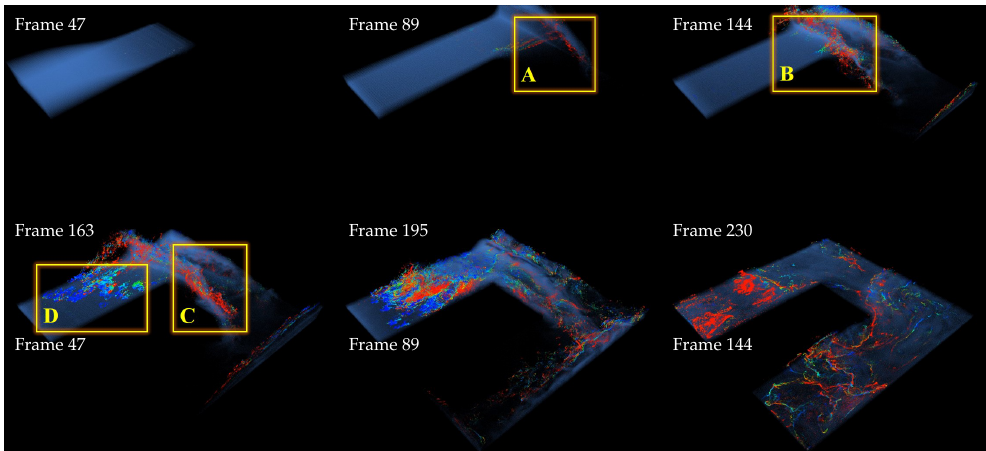
Figure 13. Tornado scene. The related video has been submitted as Supplementary Material. ( a ) Our method. ( b ) Kim and Lee [26].